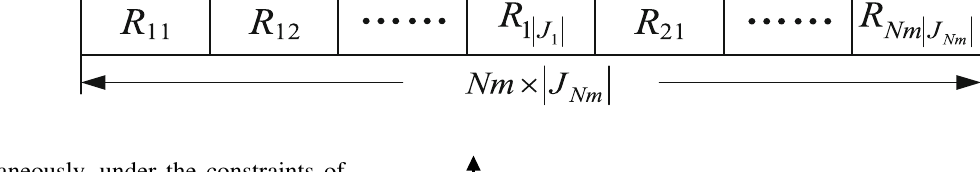
Fig. 3 Coding diagram of a single individual